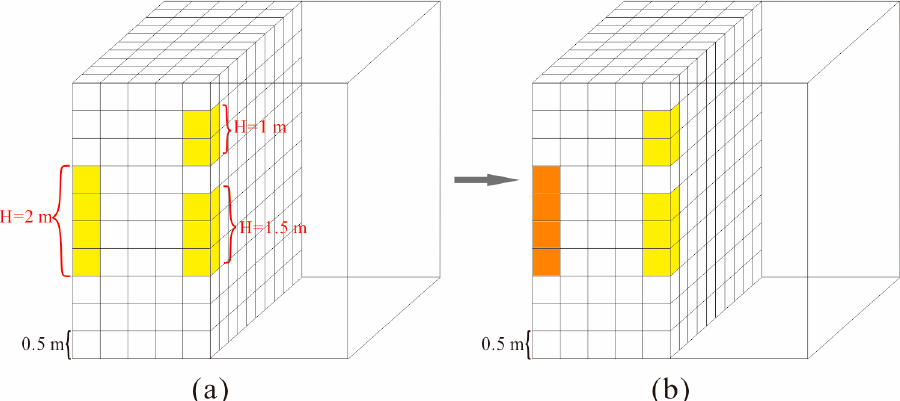
Figure 11. Analysis of the algorithm. The grid cells marked with yellow represent sandstone, and are coded as 1; while the grid elements marked with orange represent bar sand, and are coded as 2. ( a ) Original sandstone-mudstone model; ( b ) the beach-bar sandbody model which is converted from the original sandstone-mudstone model using the new algorithm.